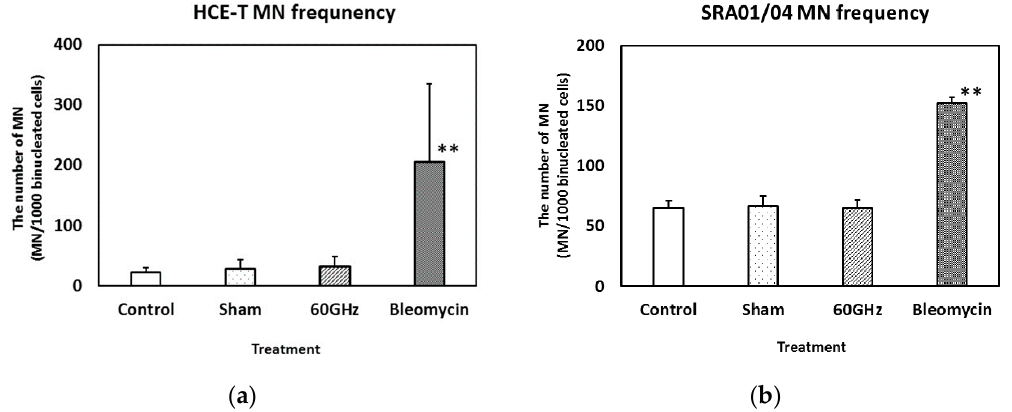
Figure 2. Micronucleus frequency in cells exposed to millimeter-wavelength radiation at 60 GHz for 24 h: HCE-T cells ( a ) and SRA01/04 cells ( b ). Treatment with bleomycin (10 μ g/mL) provided the positive controls. Data are presented as the mean ± SD from three independent experiments. Asterisks ** indicate p < 0.01. f = 0.1, (1 −β ) = 0.9903.